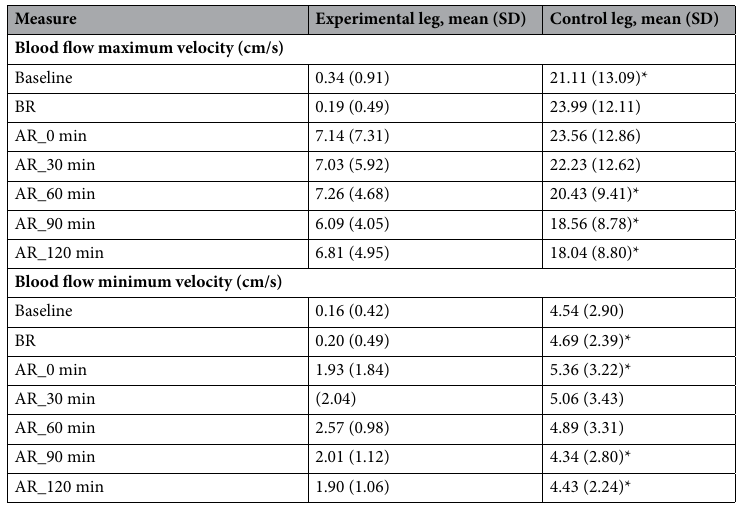
Table 1. Blood flow maximum and minimum velocity in the echogenicity group. SD standard deviation, BR before reperfusion of the common iliac artery, AR after reperfusion of the common iliac artery. *p < 0.05 between the experimental leg and control leg at the corresponding time